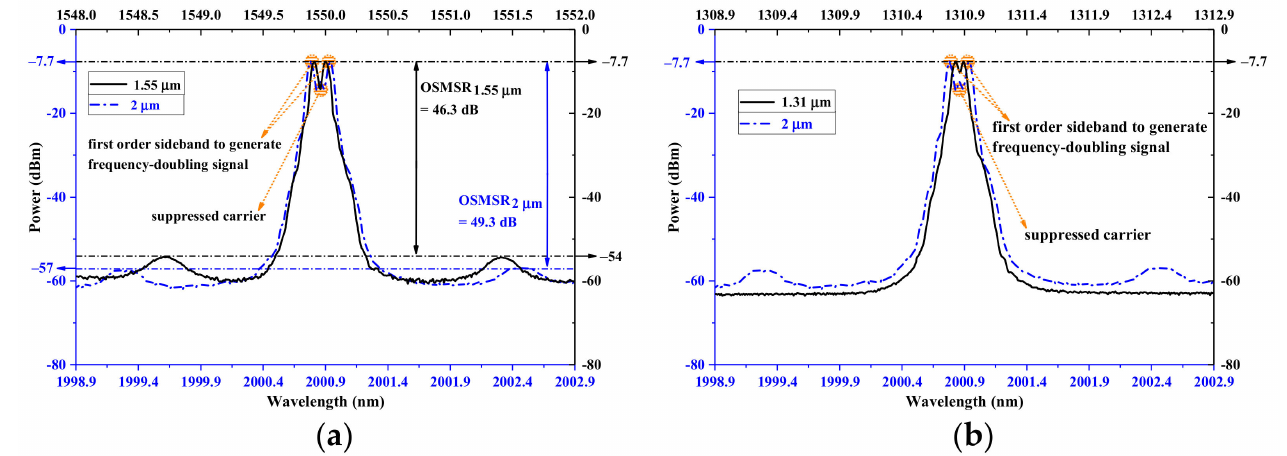
Figure 2. The optical spectrums after the DSB-CS modulation using the ( a ) 2 µ m MZM (at 2000.86 nm)/1.55 µ m MZM (at 1549.96 nm); ( b ) 2 µ m MZM (at 2000.86 nm)/1.31 µ m MZM (at 1310.82 nm).